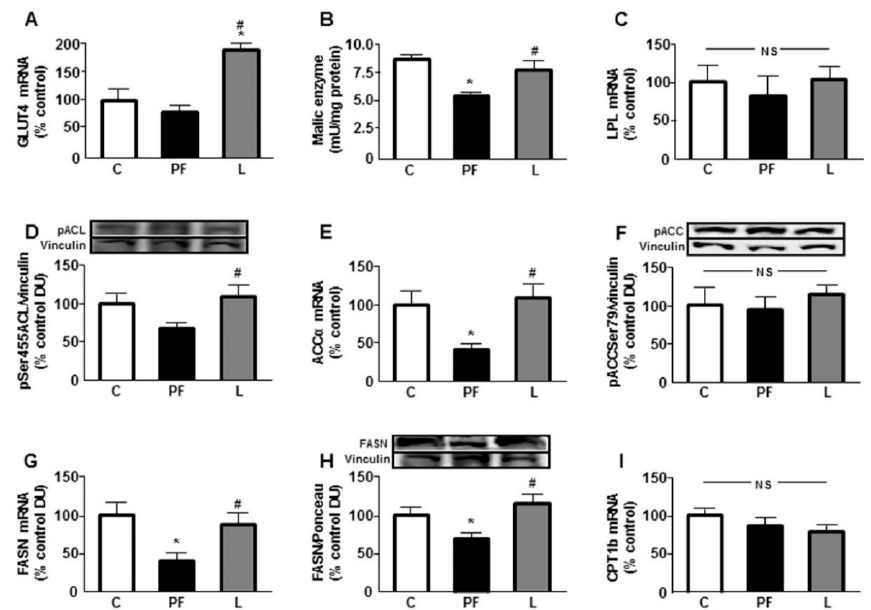
Figure 5. Metabolic response of brown adipose tissue (BAT) to icv leptin infusion. Relative ( A ) glucose transporter (GLUT)4 mRNA, ( B ) malic enzyme activity, ( C ) lipoprotein lipase (LPL) mRNA, ( D ) phosphorylated (p) protein levels of ATP citrate lyase (ACL) at Ser455 (pSer455ACL), ( E ) acetyl- CoA carboxylase (ACC) α mRNA, ( F ) phosphorylated protein levels of ACC at Ser79 (pACCSer79), ( G ) fatty acid synthase (FASN) mRNA, ( H ) protein levels of FASN, and ( I ) carnitine palmitoyl transferase (CPT)1 mRNA levels. in the interscapular BAT of control rats (C), pair-fed rats (PF) and rats receiving a chronic icv leptin infusion (L). Data are presented as means ± SEM. N = 5. DU, densitometry units; NS, non-significant. * p < 0.05 vs. C; # p < 0.05 vs.